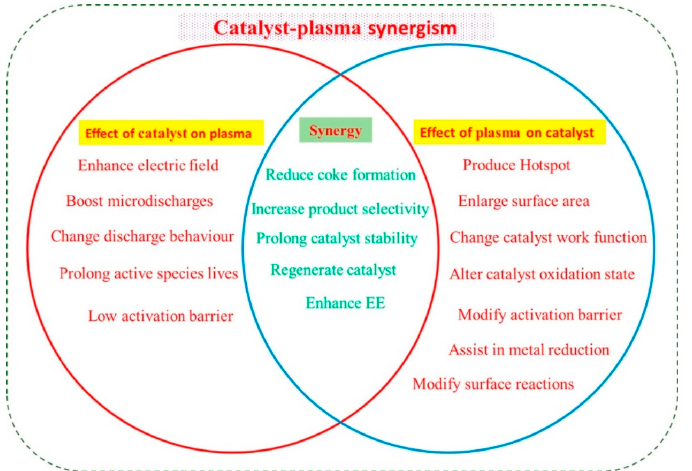
Figure 1. Synergy of the catalytic dielectric barrier discharge (DBD) plasma system. Reproduced with permission from [8], Copyright 2019,